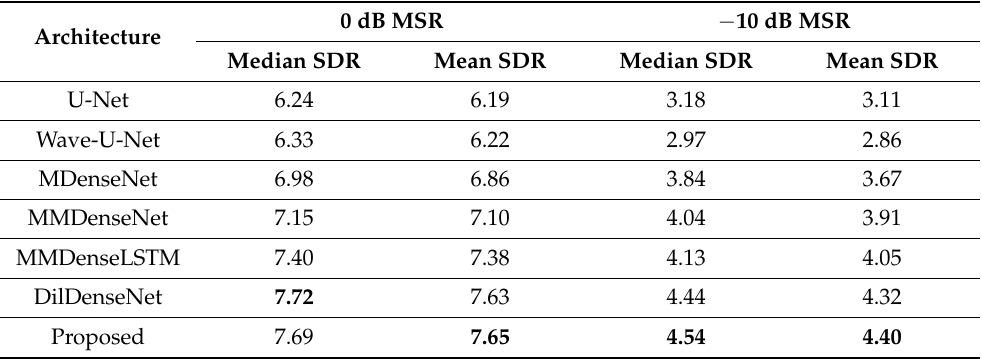
Table 7. Music separation performance measured in signal-to-distortion ratio (SDR) (dB) on broadcast contents. MSR: music-to-speech ratio.